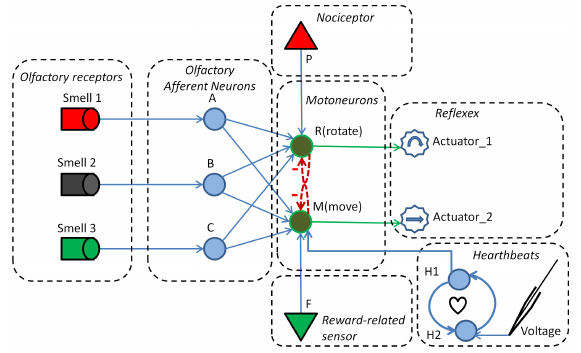
Figure 4: Neuro-inspired controller of the virtual insect